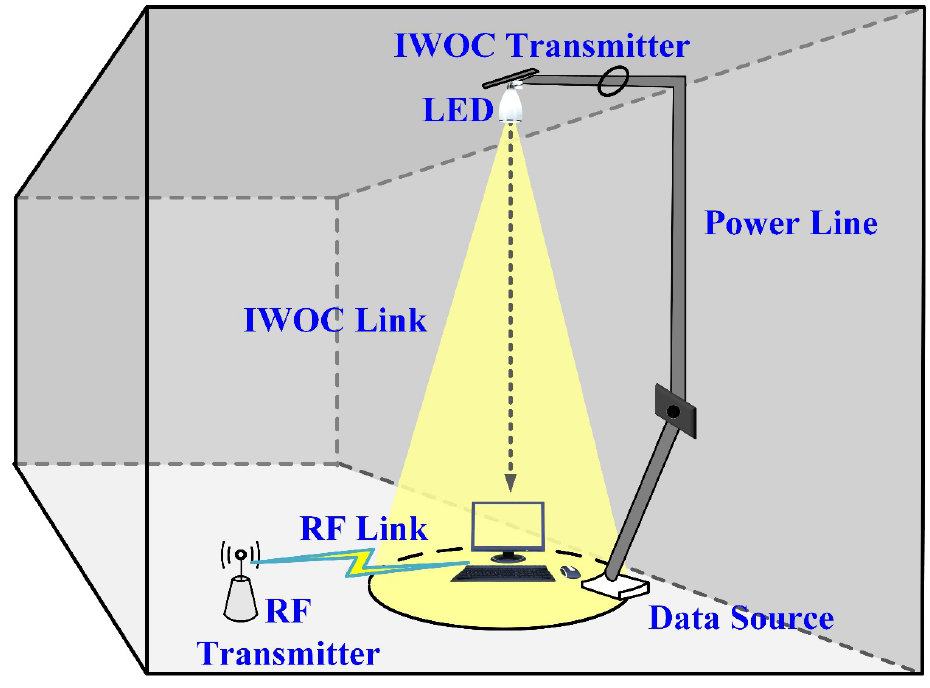
Figure 19. Hybrid PLC/IWOC/RF communication system model [12].